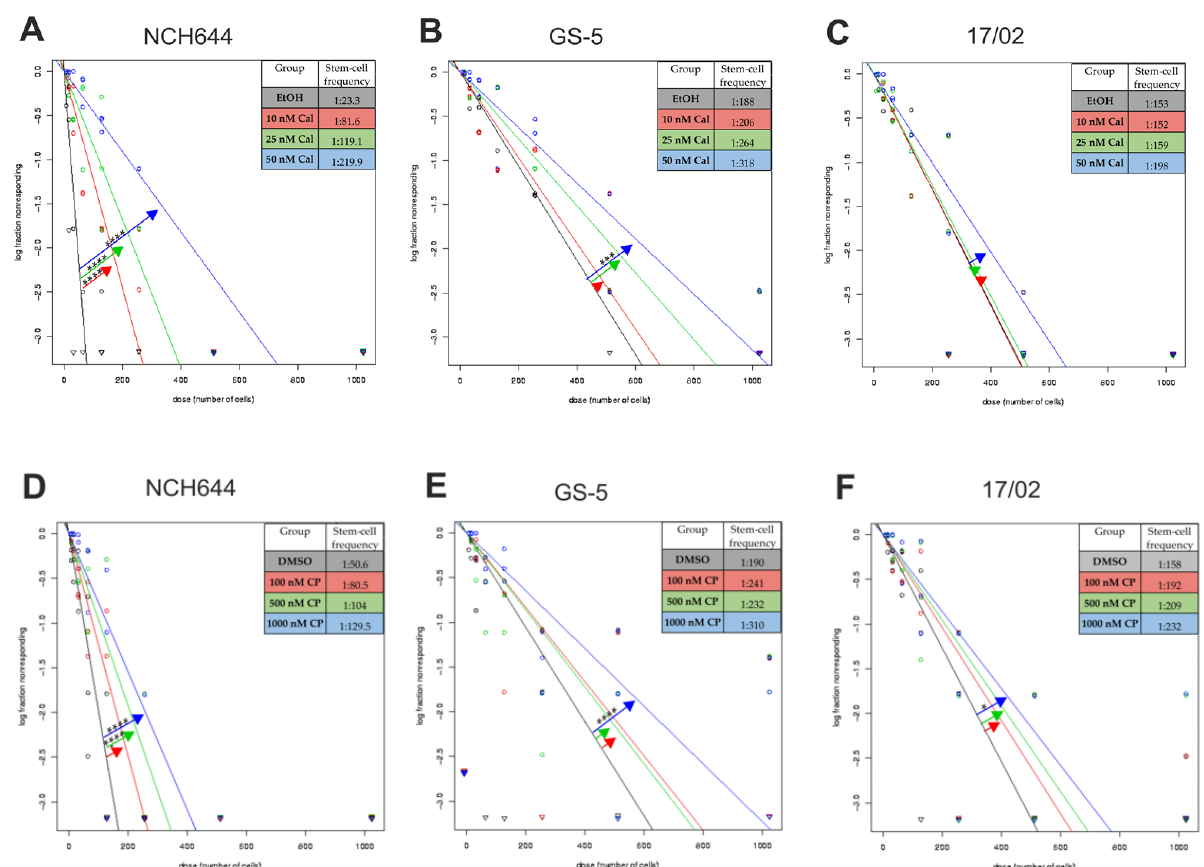
Figure 1. Calcitriol exerts differential activity among GSCs: ( A – F ) A log-fraction plot of the limited dilution model of data from ( A , D ) NCH644, ( B , E ) GS-5 and ( C , F ) 17/02 GSCs. The cells were treated with solvent (ethanol, EtOH; black) or ( A – C ) 10 (red), 25 (green) or 50 nM of calcitriol (blue) or ( D , F ) 100 (red), 500 (green) or 1000 nM of calcipotriol for 7 days after seeding the cell in a dilution series from 1024 to 8 cells and analyzing the data using ELDA software [31]. The estimated stem-cell frequency is presented under each plot. The data are the summary of at least three experiments performed with 12 replicates per cell number and 8 different cell numbers seeded. * p < 0.05; ** p < 0.01; *** p < 0.001; **** p < 0.0001; chi-square-test from ELDA Web-App [31].